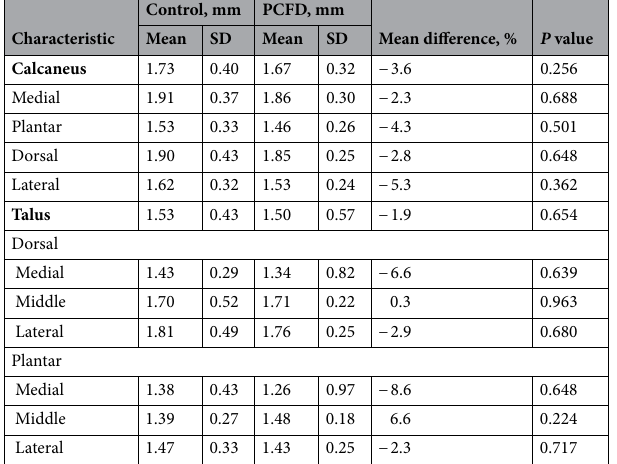
Table 3. Means and standard deviations for 3-dimensional distance maps, measured in millimeters, and mean differences in the distances in the Chopart joint when comparing patients with progressive collapsing foot deformity and controls, with P values for the comparisons. SD standard deviation, PCFD progressive collapsing foot